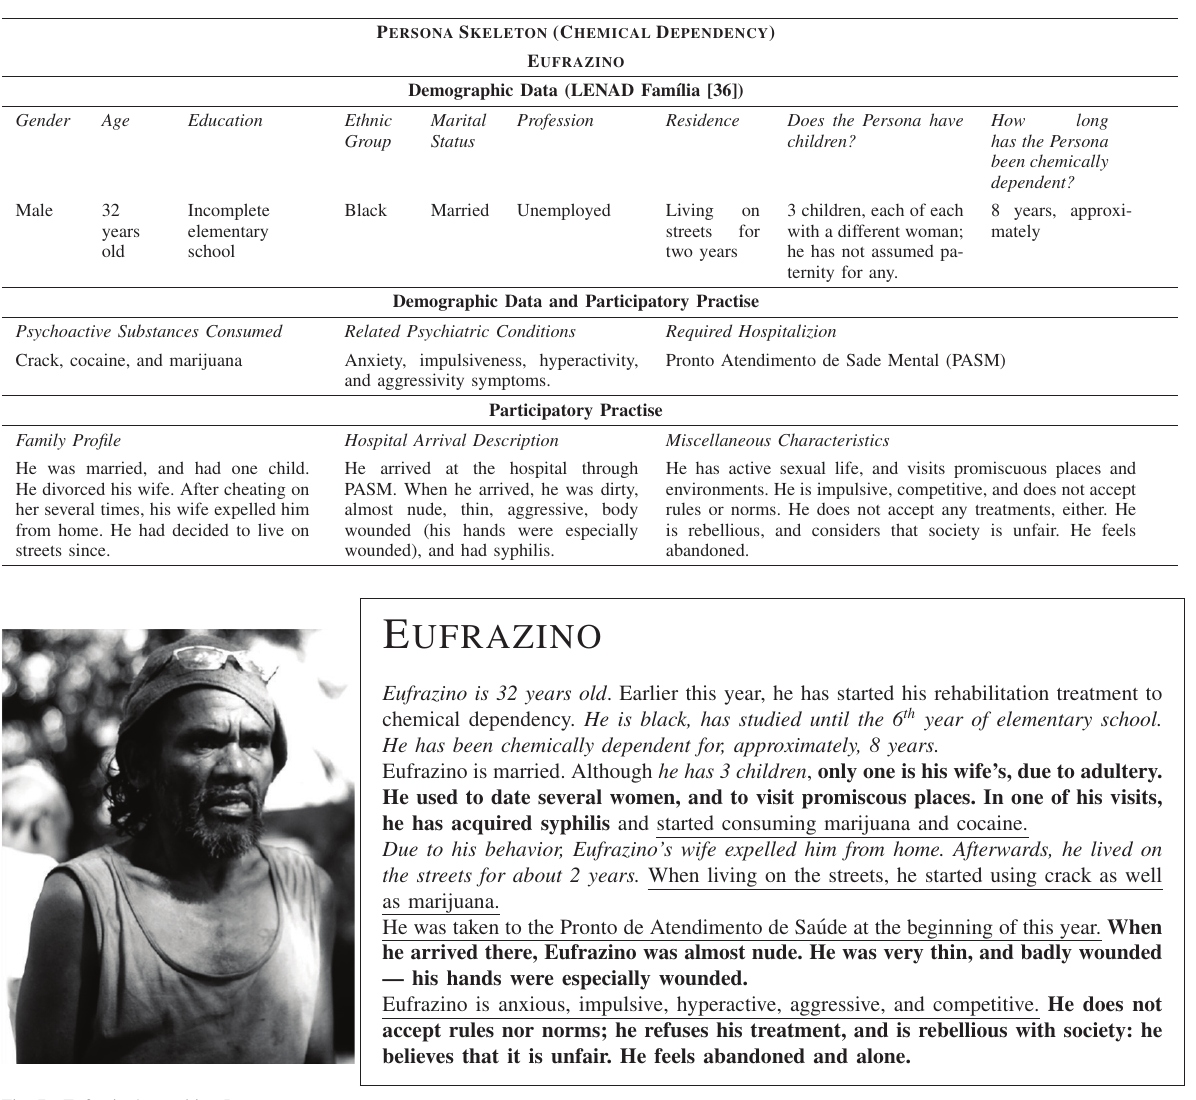
Fig. 7. Eufrazino’s resulting Persona.